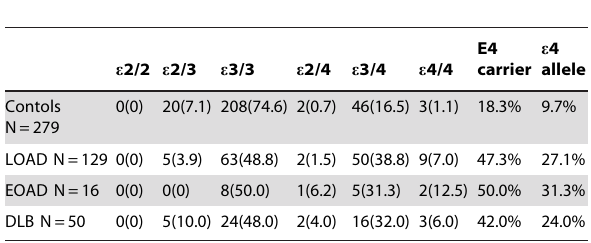
Table 2. ApoE4 carrier status and the frequency of the e 4 allele in Controls, LOAD, EOAD, and